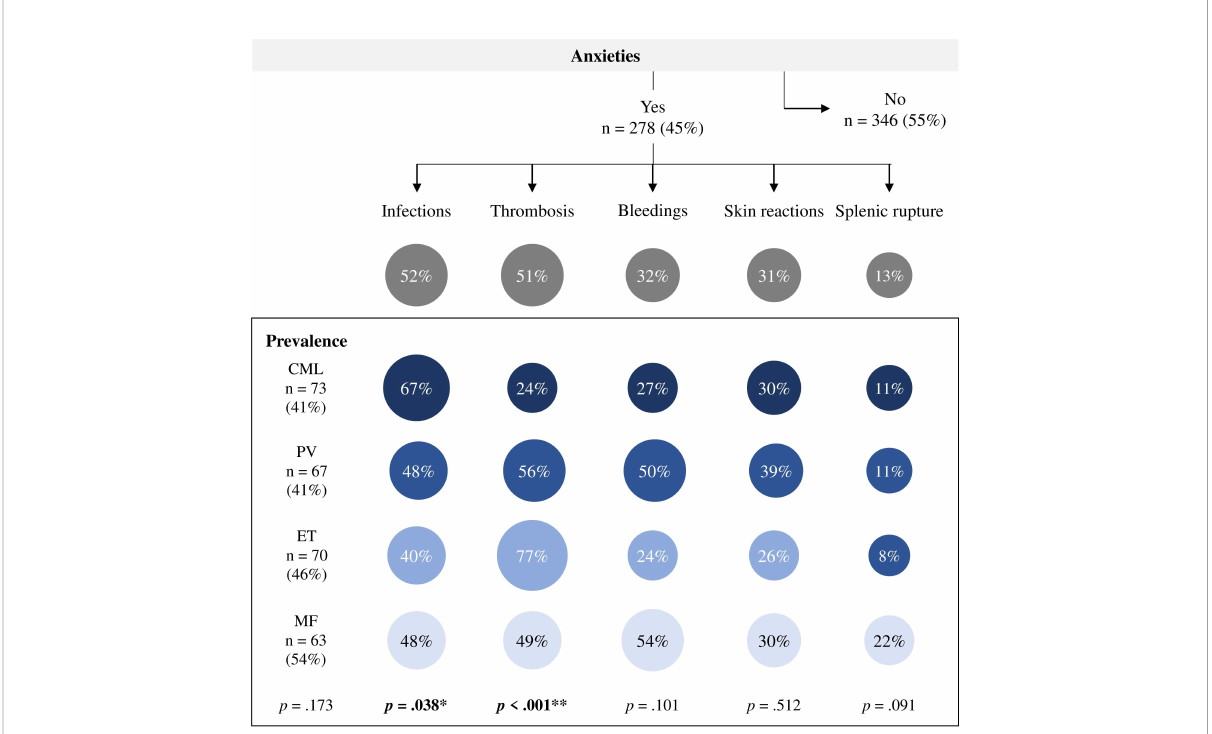
FIGURE 3 Anxieties during physical activity in patients with myeloproliferative neoplasms (n = 624). n, number of patients; CML, chronic myeloid leukemia (n = 178); PV, polycythemia vera (n = 164); ET, essential thrombocythemia (n = 155); MF, myelo fi brosis (n = 117). bold: statistically signi fi cance, * p ≤ 05, ** p ≤ 001.